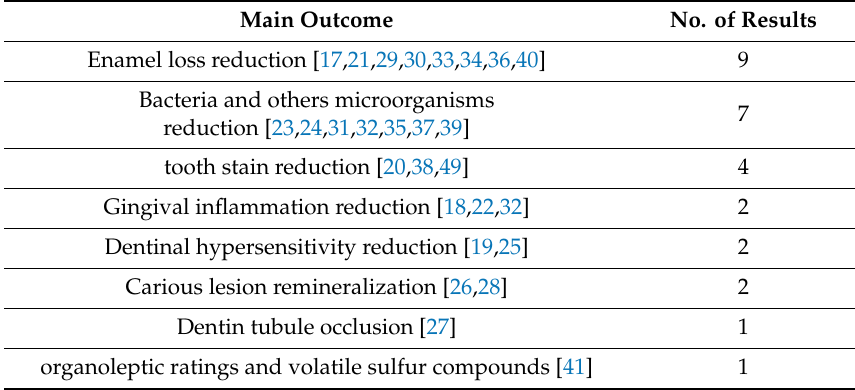
Table 3. Main outcome table as specified in summary measures paragraph.